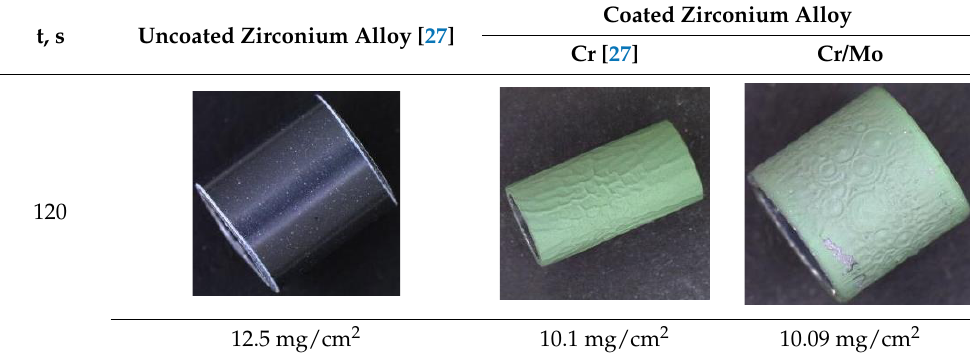
Figure 1. Weight gains of the uncoated, Cr-, and Cr/Mo-coated Zr alloy after oxidation at 1330 °C as a function of oxidation time. Table 4. The outer view and weight gain (in mg/cm 2 ) of the samples after oxidation at 1400 °C.